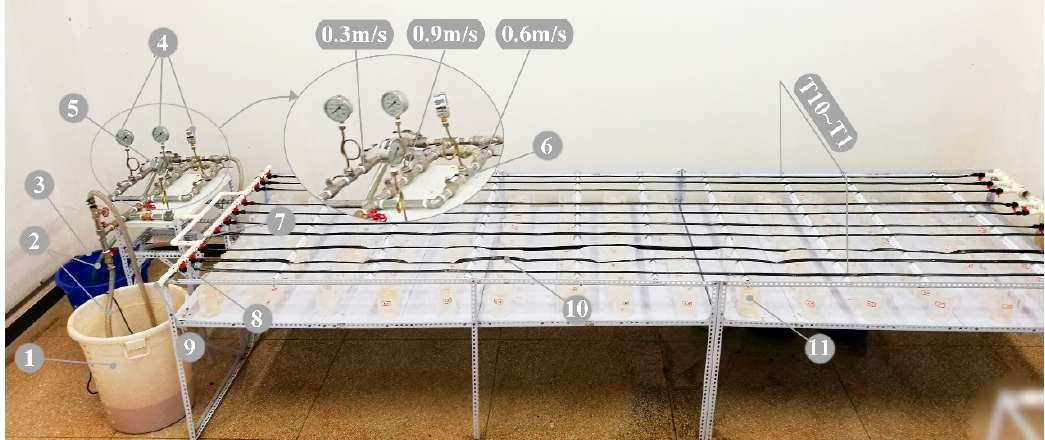
Figure 2. Experimental setup. 1, muddy water tank; 2, submersible pump; 3, clean water tank; 4, manometer I; 5, manometer II; 6, pressure adjustment valve; 7, polyvinyl chloride (PVC) pipe; 8, control valve; 9, PVC choke plug; 10, lateral; 11, measuring cup.